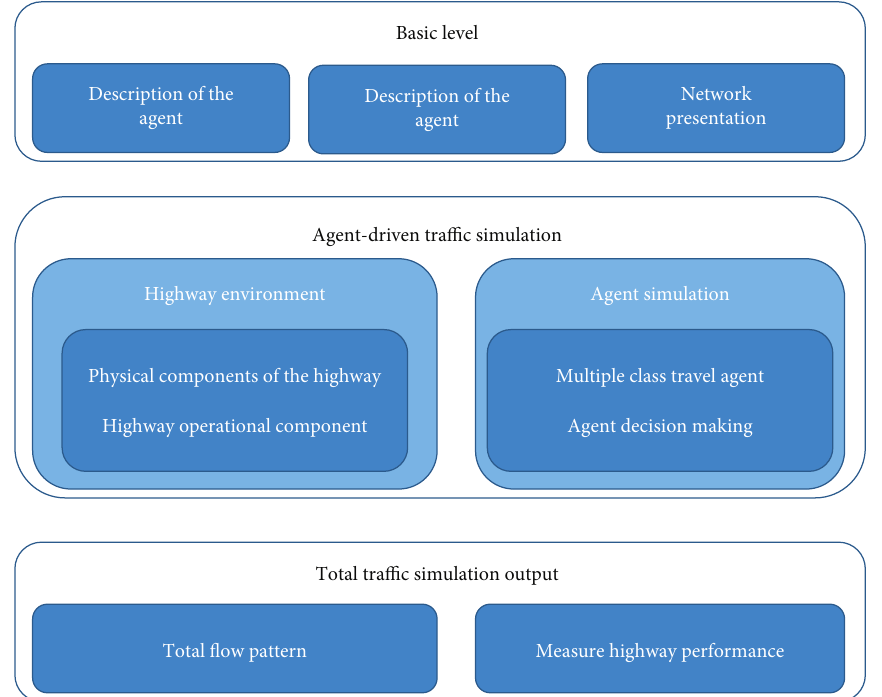
Figure 6: The general structure of the factor-based simulation framework shown by the proposed traffic simulation model.